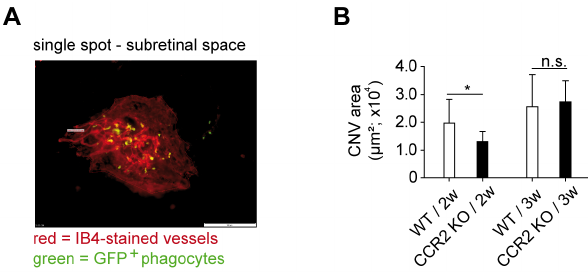
Figure 5. CCR2-deficiency temporarily reduced CNV areas in choroidal flatmounts. (A) Fluorescence microscopy of Isolectin B4- stained choroidal flatmounts of eyes from CX 3 CR1-GFP reporter mice showing the endothelium in neovascular areas with GFP + phagocytes (single spot; scale bar=100 m m). (B) Isolectin B4 (IB4)-positive CNV areas from CX 3 CR1 reporter mice lacking (black bar) or expressing CCR2 (black bar) after 2 (2w) or 3 weeks (3w) following laser treatment. Bar graphs show means 6 SD. A total of 3–5 mice were used per group 2 independent experiments. CNV areas were analyzed by the two-tailed nonparametric Mann-Whitney-U-Test. The statistical significance was analyzed as indicated (*p , 0.05, n.s. = not significant).